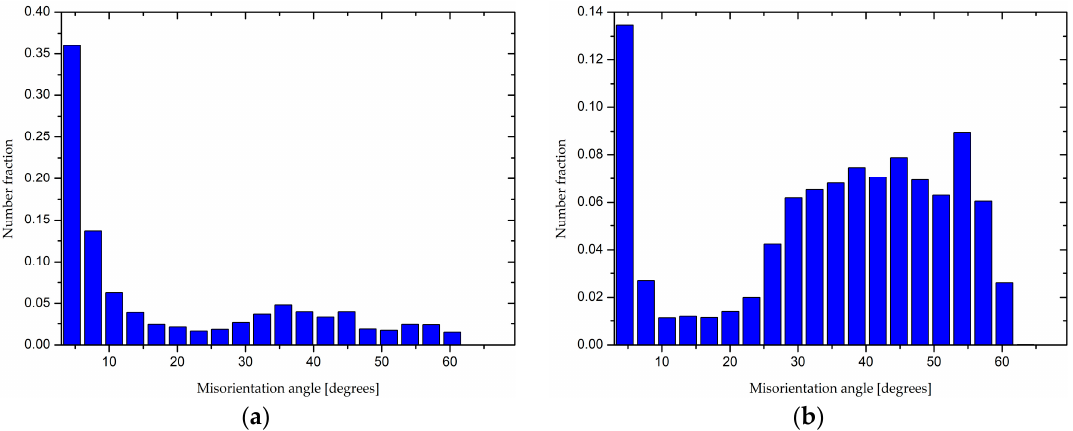
Figure 6. Misorientation angle distribution of the AlMg5 alloy samples ( a ) ST + ECAP 2× + ageing 160 °C for 4 h and ( b ) ST + ECAP 2× + ageing 180 °C for 4 h.